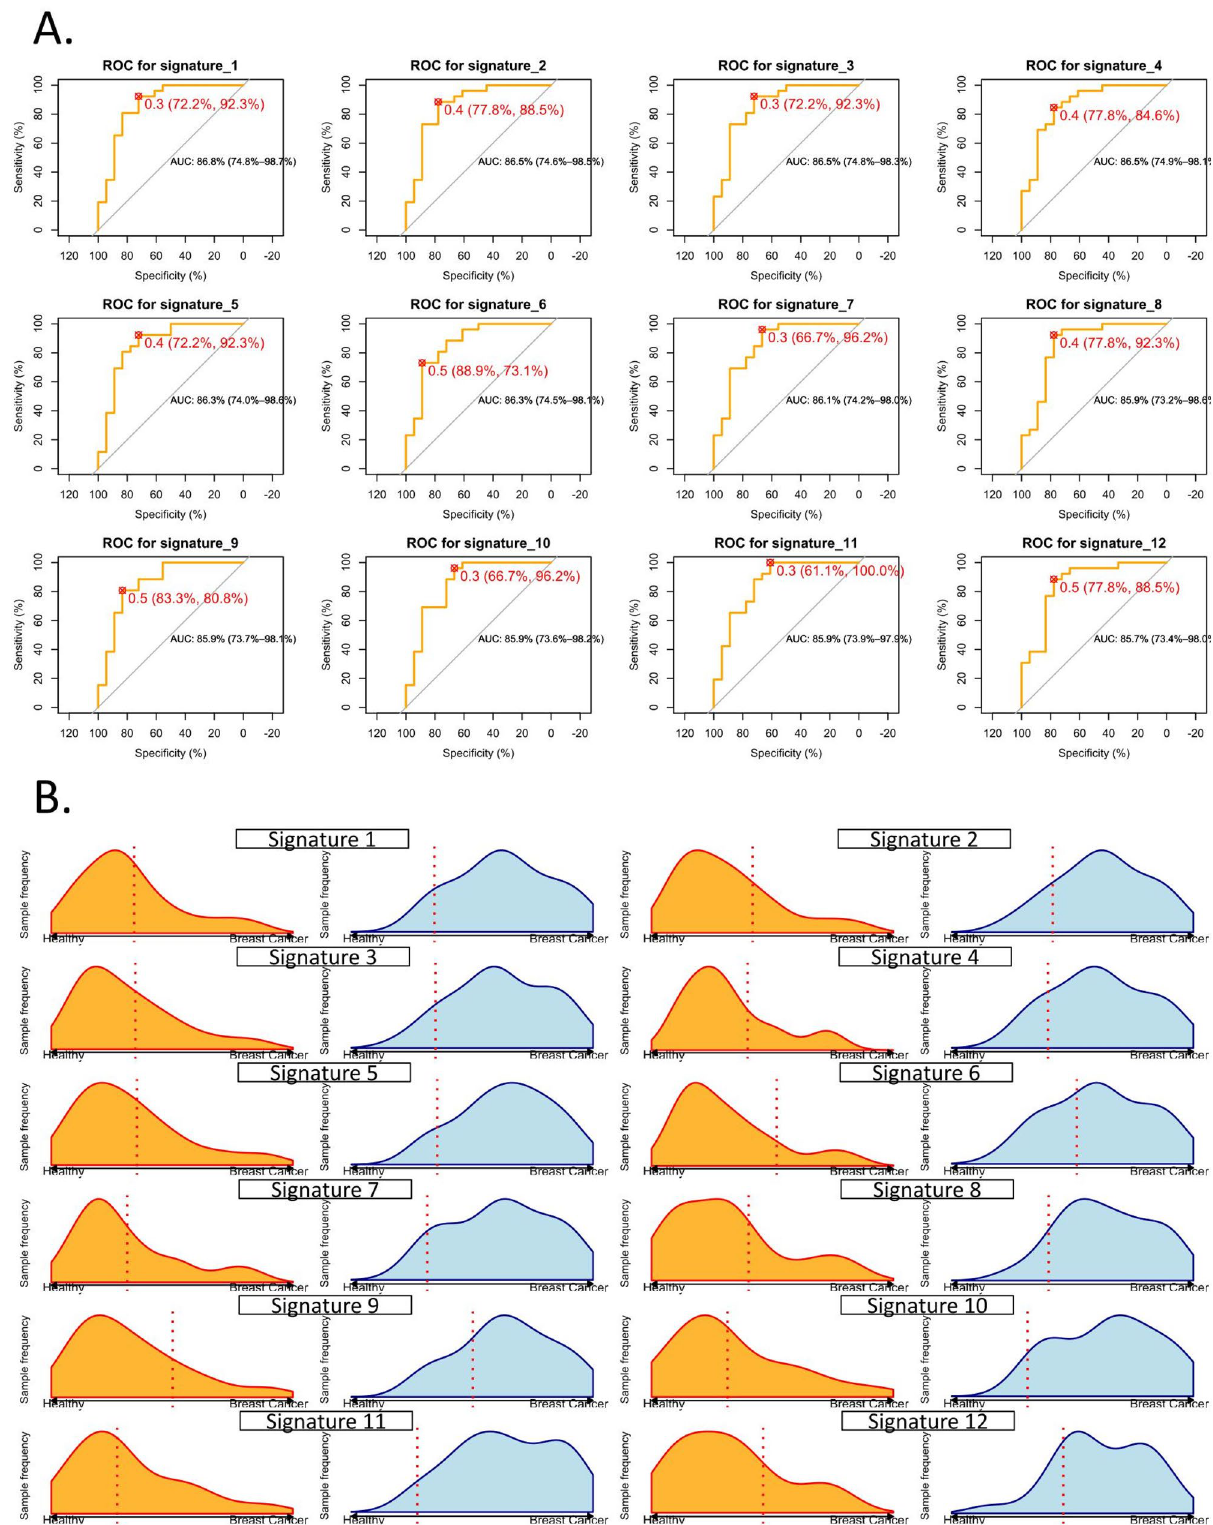
Figure 6. Performances of the 12 best circulating microRNA signatures able to discriminate breast cancers from healthy women in Rwandan-recruited subjects. ( A ) ROC curve analysis, optimal cut-off, and corresponding specificity and sensibility (red brackets) of the top signatures. Optimal cut-offs are calculated using the Youden index and are displayed in red. The confidence intervals of the AUC values are displayed in black brackets ( B ) Model outcome distributions for the breast cancer and healthy subjects. The x-axis corresponds to the model predictions. The dashed line represents the chosen threshold used to compute the sensitivity and specificity values for each group. Orange distribution contains healthy subjects; breast cancer subject distributions are displayed in blue. Names of the signatures are referring to Table